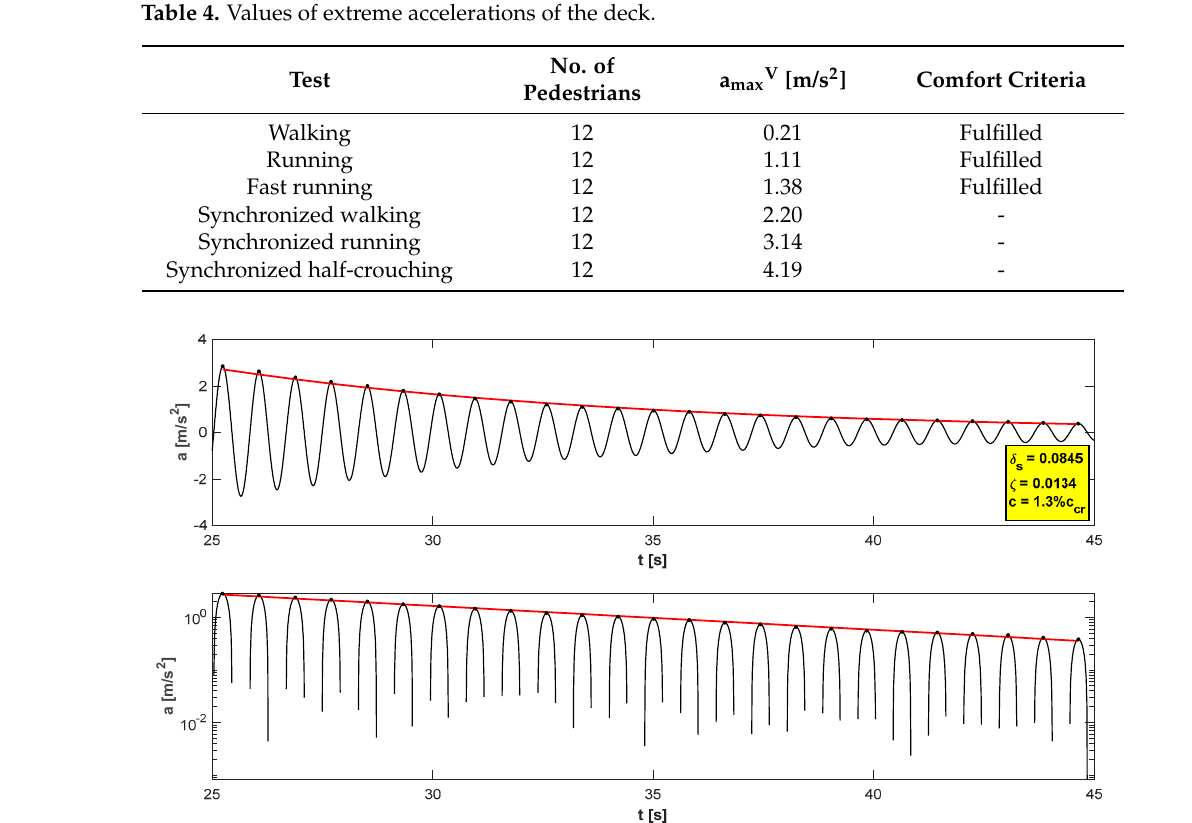
Figure 19. Determination of the damping coefficient.